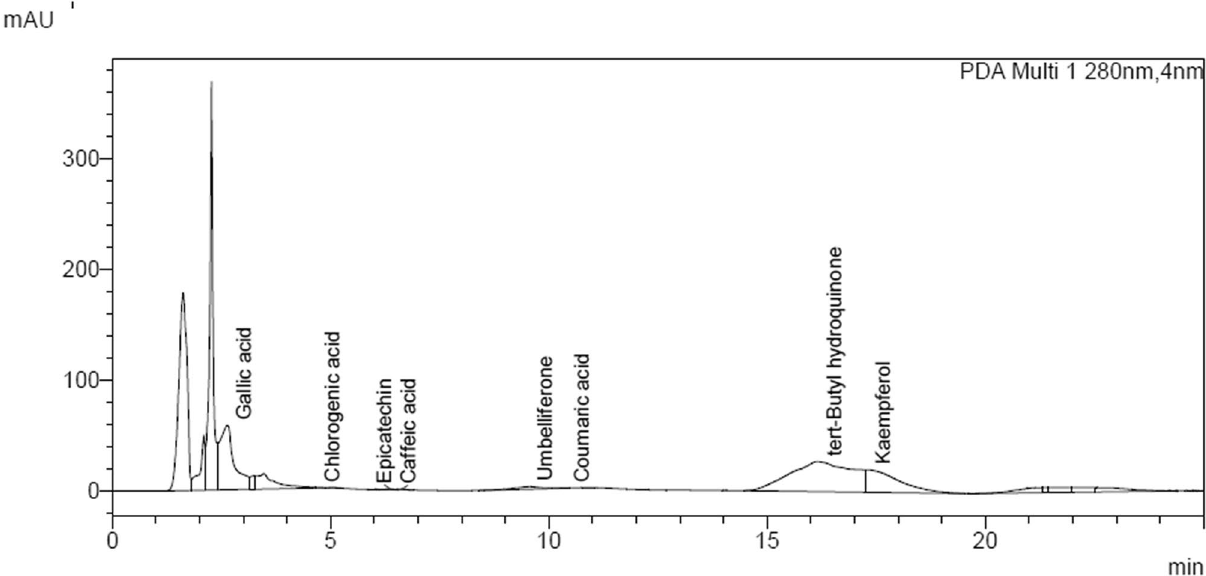
Figure 1. Representative profile of HPLC chromatogram of different polyphenols detected in aqueous extract of leaves of Royale cinerea (D.Don) Baillon, where (peak 1): Gallic acid , (peak 2): Chlorogenic acid, (peak 3): Epicatechin, (peak 4): Caffeic acid, (peak 5): Umbelliferone, (peak 6): Coumaric acid, (peak 7): tert-Butyl hydroquinone (peak 8), Kaempferol respectively were recorded at 280 nm.